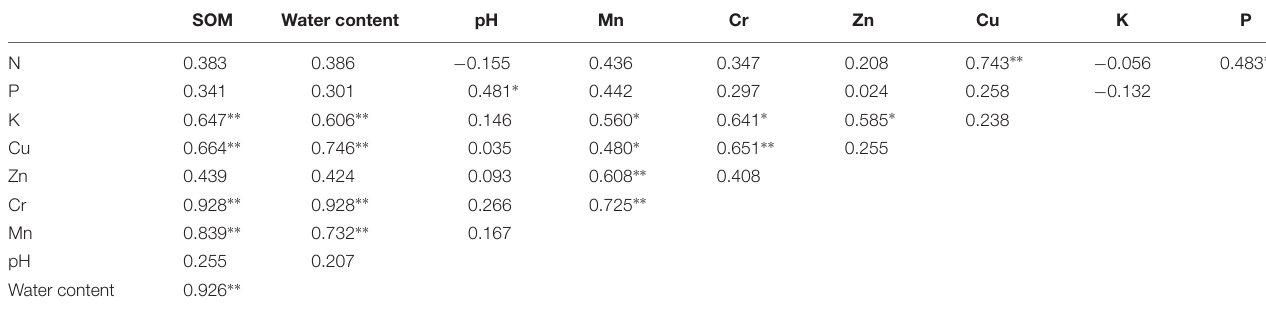
TABLE 2 | Spearman’s correlation coefficients between environmental variables.